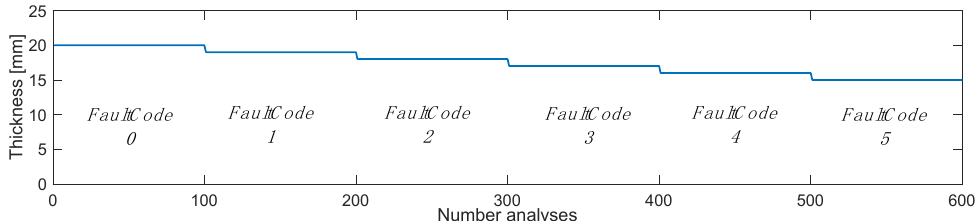
Figure 5. Outline of analysis performed for AI training.